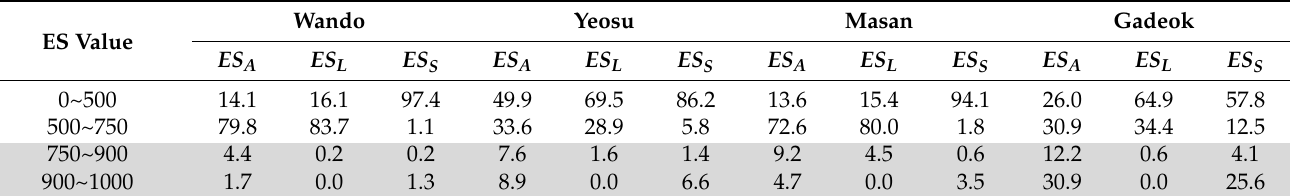
Table 8. ES value for each destination fairway.